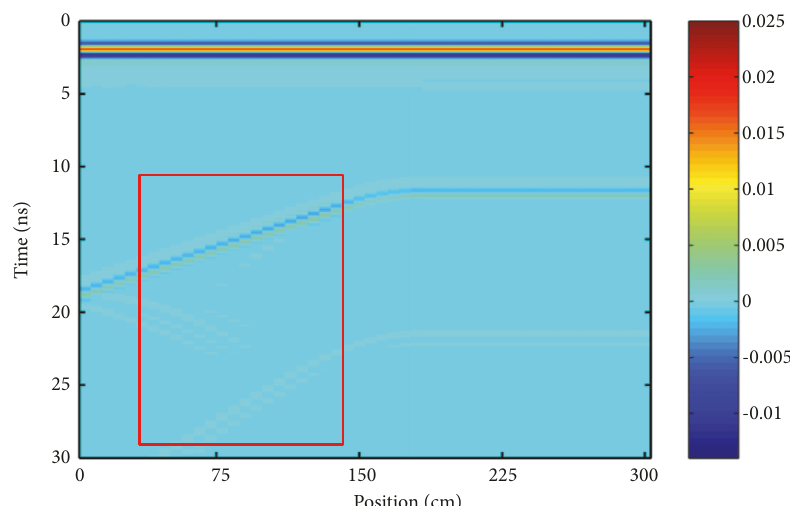
Figure 11: The wiggle trace profile of the embankment model simulated by the traditional conformal SPRK methods.